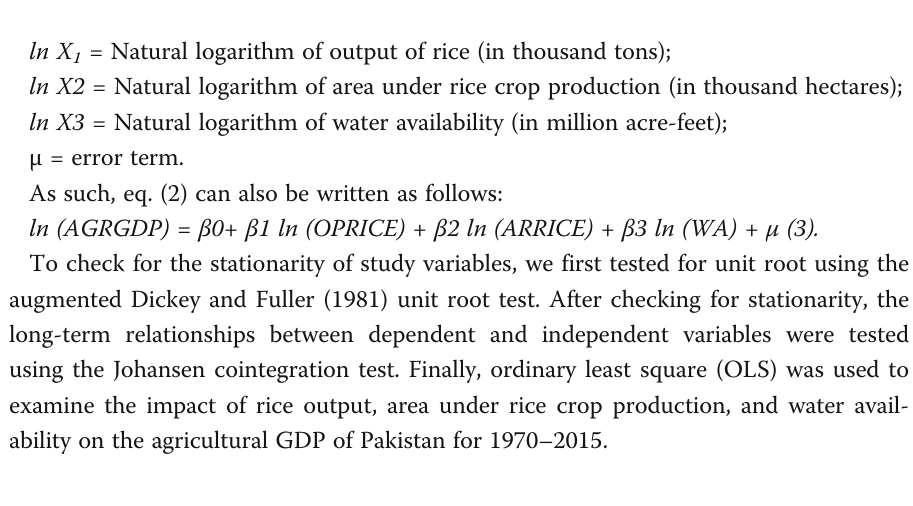
t-Statistic Critical values (0.5189) (0.0067) (0.0000) (0.6812)